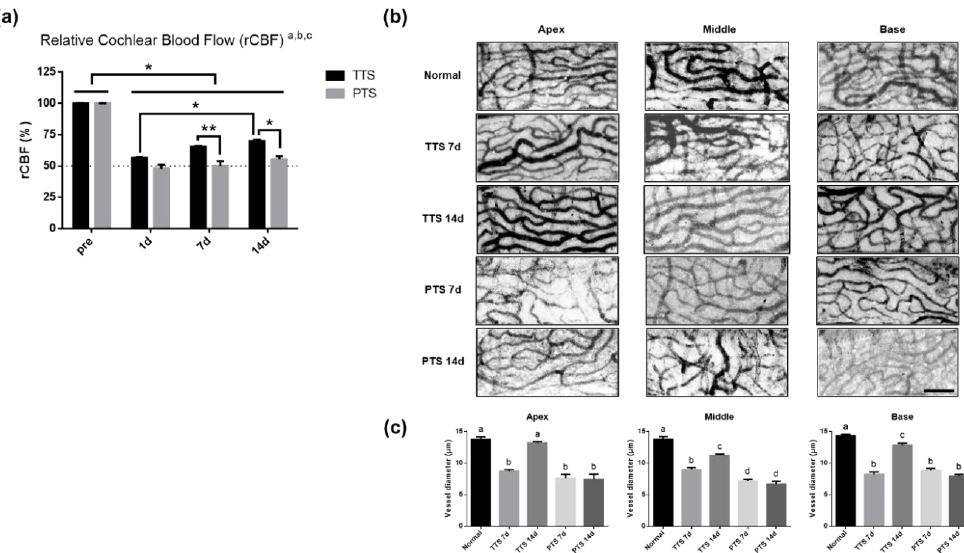
Figure 4. Changes of cochlear blood flow and microvasculature of stria vascularis after noise exposure. ( a ) The cochlear blood flow was measured in TTS and PTS groups pre and post (1 d, 7 d, and 14 d) noise exposure. Both TTS and PTS significantly decreased cochlear blood flow at 1 d post noise exposure. The blood flow significantly increased in the TTS group as compared with the PTS group at 7 d and 14 d post noise exposure. TTS, transient threshold shift; PTS, permanent threshold shift; a, main effect of day, p < 0.05; b, main effect of treatment, p < 0.05. c, interaction, p < 0.05; * p < 0.05, ** p < 0.01. All graphs represent mean ± S.E.M. Two-way ANOVA, Tukey’s multiple comparisons test. ( b ) Endothelial cells of stria vascularis were stained with anti-PECAM antibody, and confocal images were obtained before (normal) and after (7 d and 14 d) noise exposure (TTS or PTS). Representative pictures of confocal images. Scale bar represents 100 μm. ( c ) Capillary thickness was measured in diameter and quantified. The vessel diameter in apex was significantly decreased by PTS at 7 d and 14 d as compared with normal animals, while that of TTS recovered toward normal thickness at 14 d. All graphs